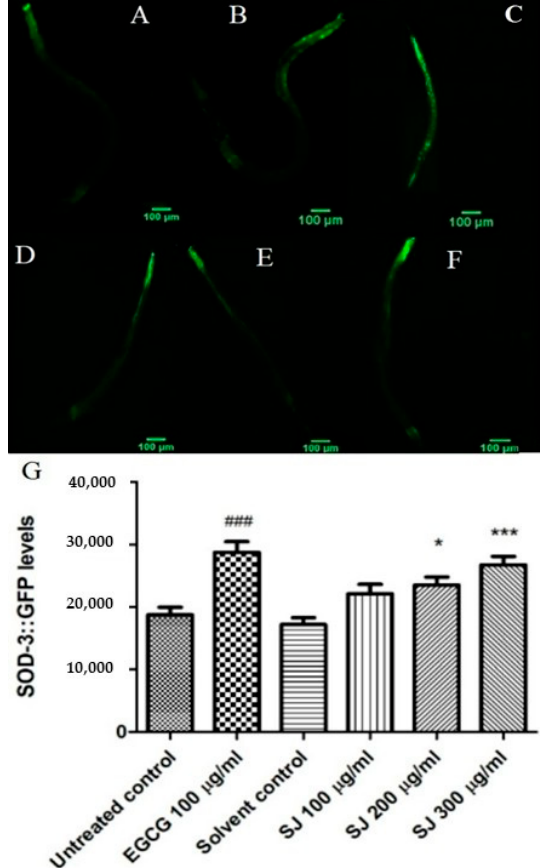
Figure 5. Expression of Sod-3 gene in C. elegans . (A–F) Photos of GFP fluorescence in the posterior part of the intestine of CF1553 worms from different treatment groups: (a) untreated control group, (b) solvent control, (c) EGCG 100 µg/mL, (d) SJ 100 µg/mL, (e) SJ 200 µg/mL, (f) SJ 300 µg/mL, and (g) quantification of sod-3 levels through fluorescence intensity measurement for different groups. The highest concentration of SJ extract used—SJ 300 µg/mL—resulted in significant expression of sod-3 gene. Data is represented as mean of three assays analyzed through one-way ANOVA followed by Bonferroni’s method. * p < 0.05, *** p < 0.001 in comparison with solvent control and ### p < 0.001 in comparison with untreated control group.